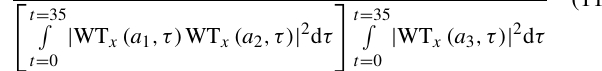
value close to unity reveals a maximum amount of coupling, and a value close to zero corresponds to a random phase re- lation.